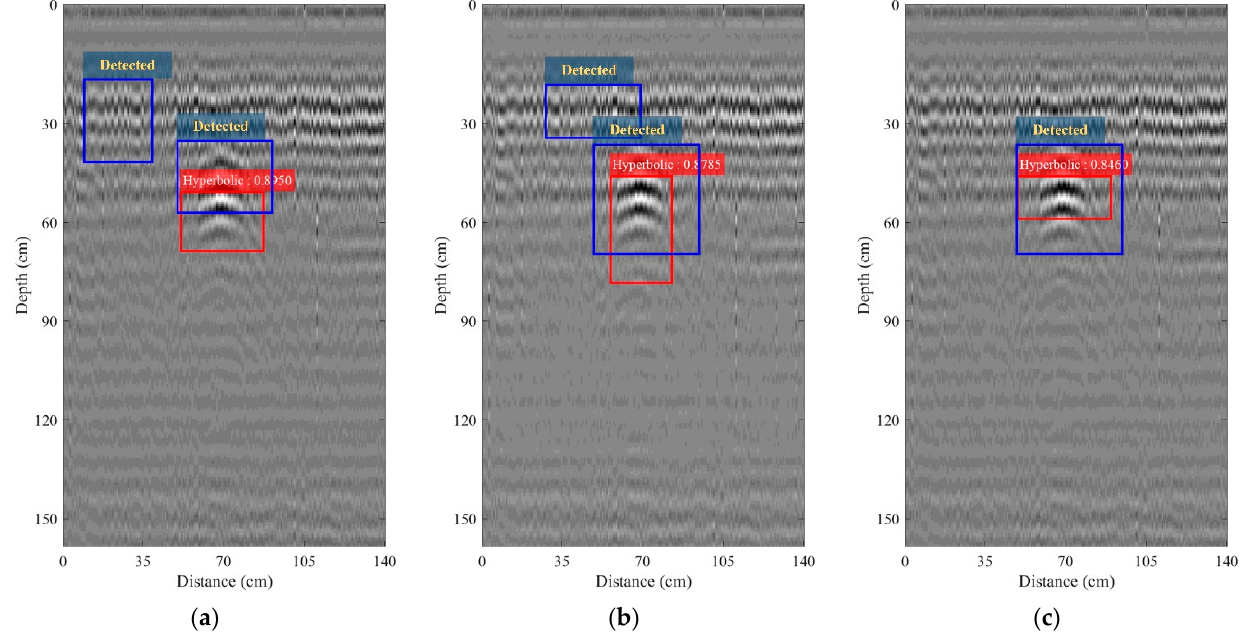
Figure 14. B-scan images collected by using the pickup truck-mounted GPR system on the road and obtained from performing bandpass filtering: ( a ) Bf = 100 MHz; ( b ) Bf = 150 MHz; ( c ) Bf = 200 MHz.